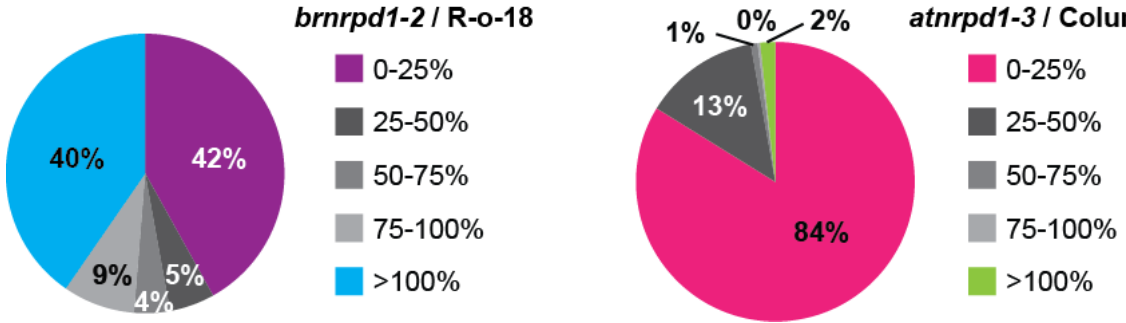
Figure 6. Pol IV-dependent siRNA loci in B. rapa and Arabidopsis. Small RNA-generating windows were divided into five groups based on the degree of sRNA accumulation in the brnrpd1-2 or atnrpd1-3 mutants compared to respective wild